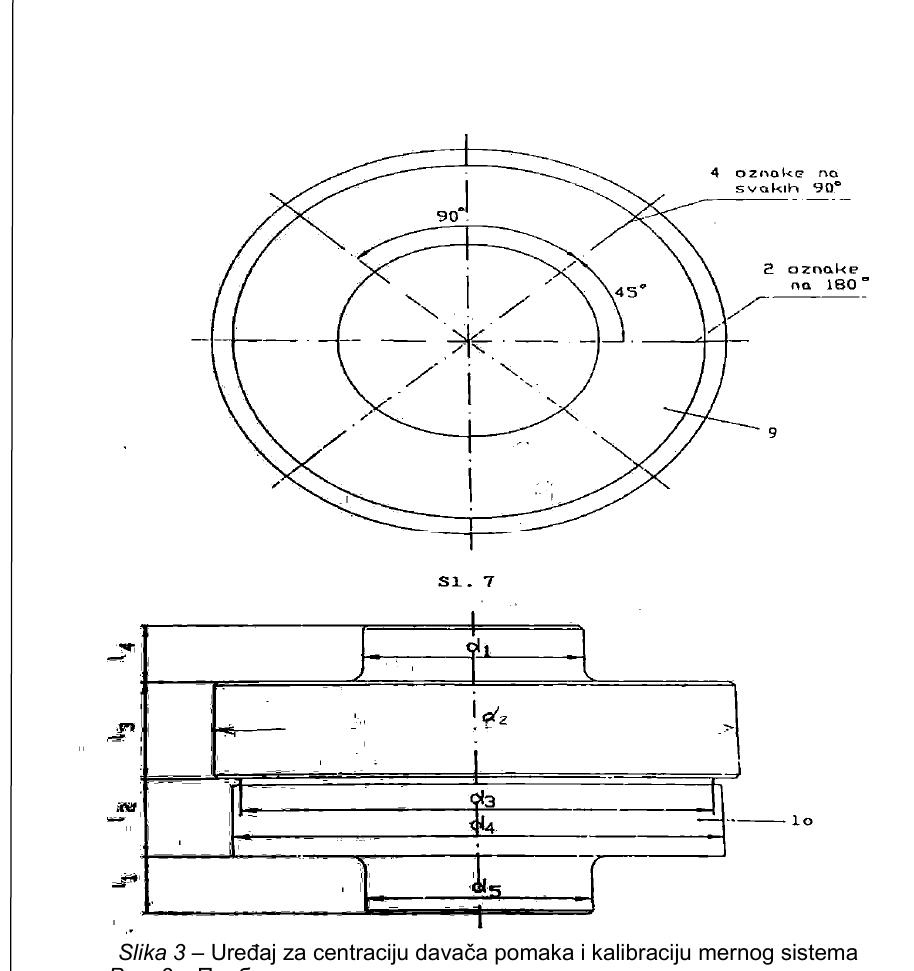
и калибровки измерительной установки Figure 3 – Device for displacement sensor positioning and measurement system